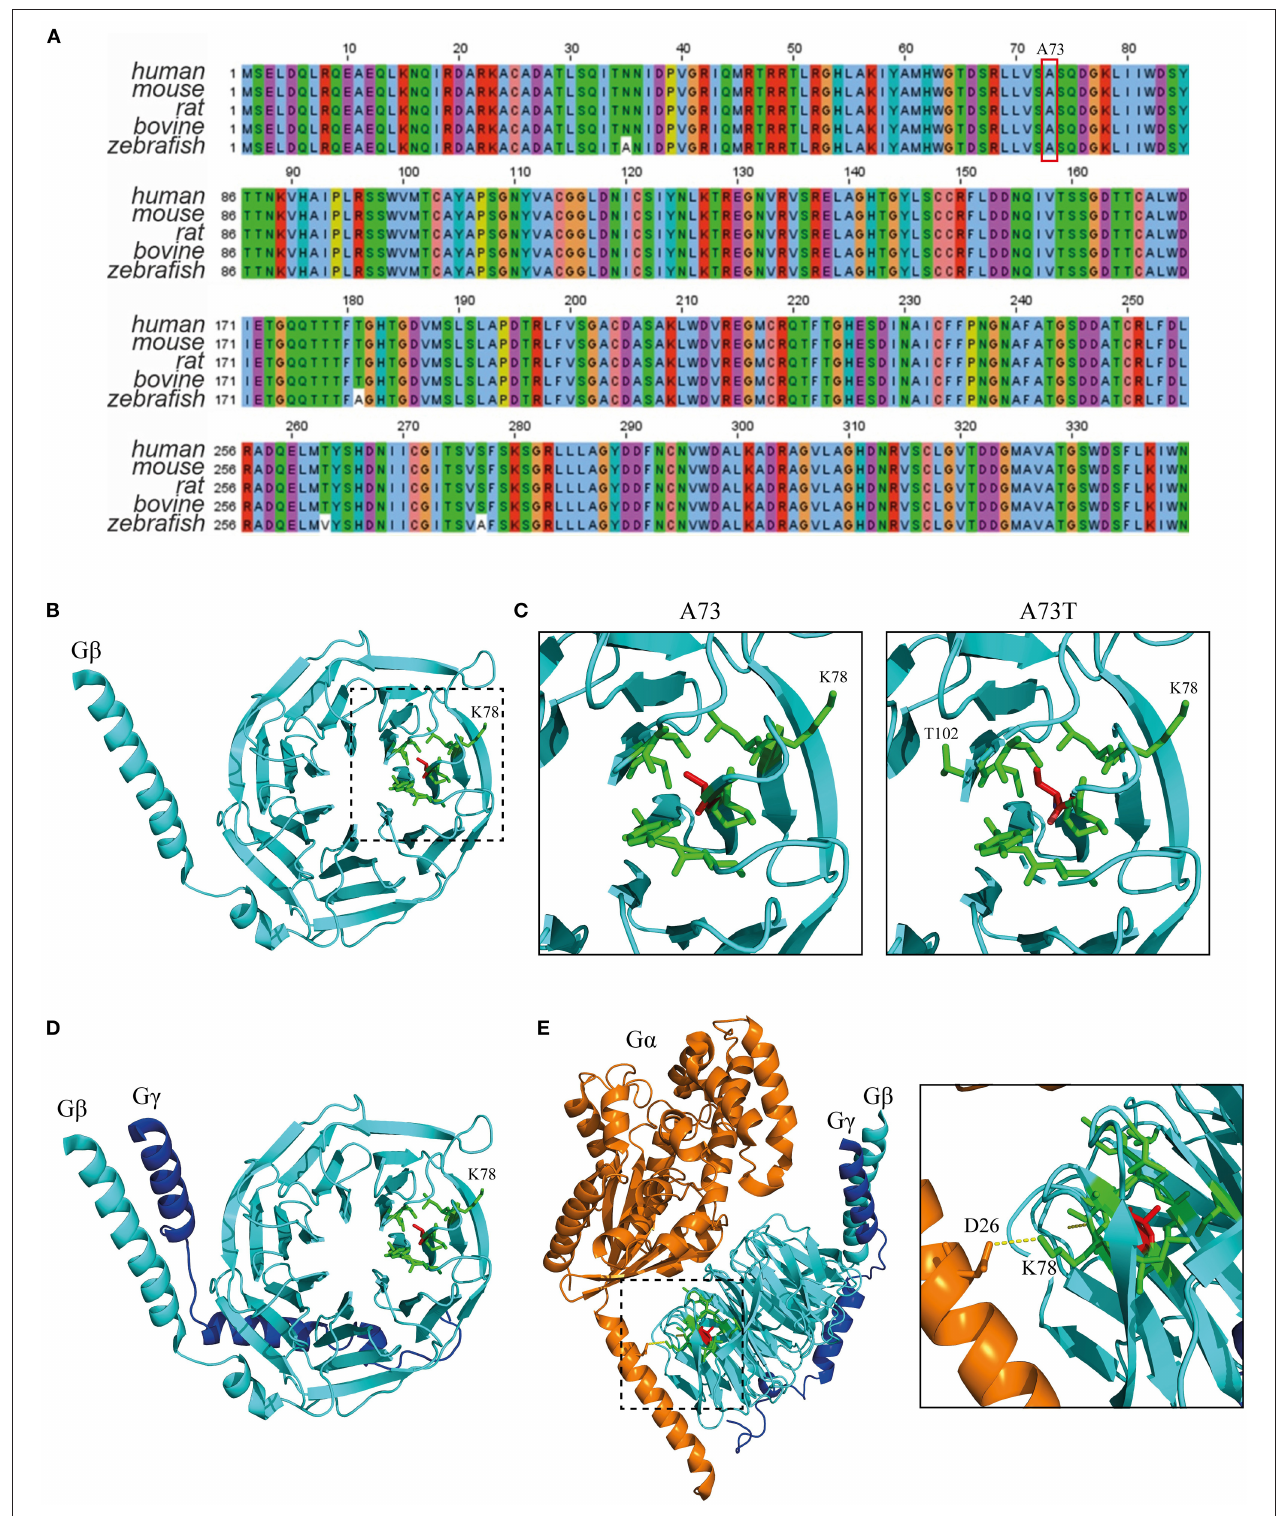
FIGURE 2 | The A73T mutation might compromise a WD40 repeat from the WD40 domain of GNB1. (A) Sequence alignment of GNB1 protein from different species demonstrating that the amino acid sequence is almost unchanged across evolution. The alignment was performed using Jalview (Version 2) software